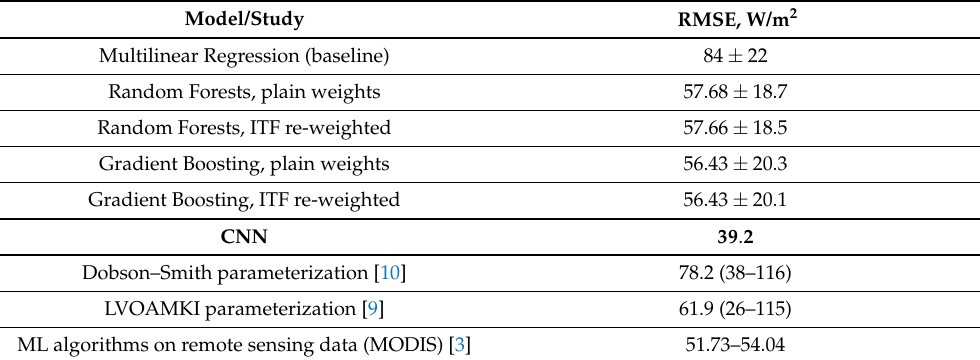
Table 4. Quality metrics of ML models exploited in this study, parameterizations of SW radiation known from the literature [9,10], and an algorithm based on machine learning for estimating down- ward SW flux using remote sensing (MODIS) imagery [3]. Best model along with its quality metric are highlighted using bold